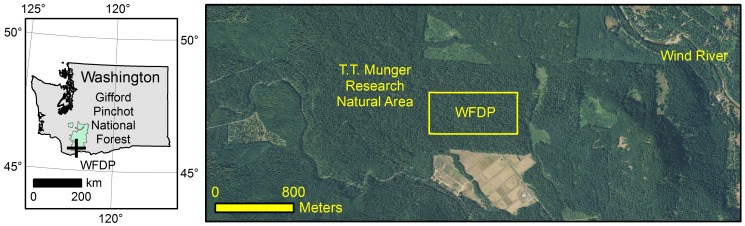
The Wind River Forest Dynamics Plot (WFDP) is located in the T.T. Munger Research Natural Area of the Gifford Pinchot National Forest (left, green) in the Tsuga heterophylla zone of western Washington, USA.The plot is located in a patch of late-successional forest. The area surrounding the Research Natural Area has had ongoing harvesting beginning in the late 19th century.